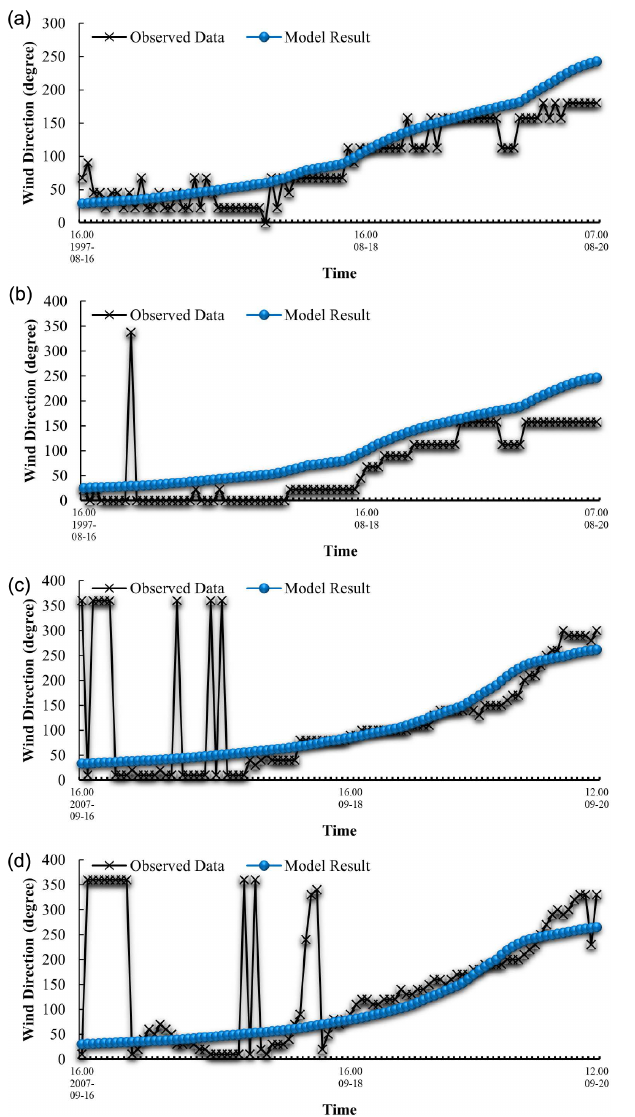
Figure 6. Data comparison between computed wind direction (de- gree) and observed data at the two wind gauge stations in Shang- hai during typhoons Winnie and Wipha. The blue line presents the simulated results from the typhoon model, while the black line in- dicates the measured data at the gauge stations. (a, b) Winnie and (c, d) Wipha at Daji and Tanxu stations.